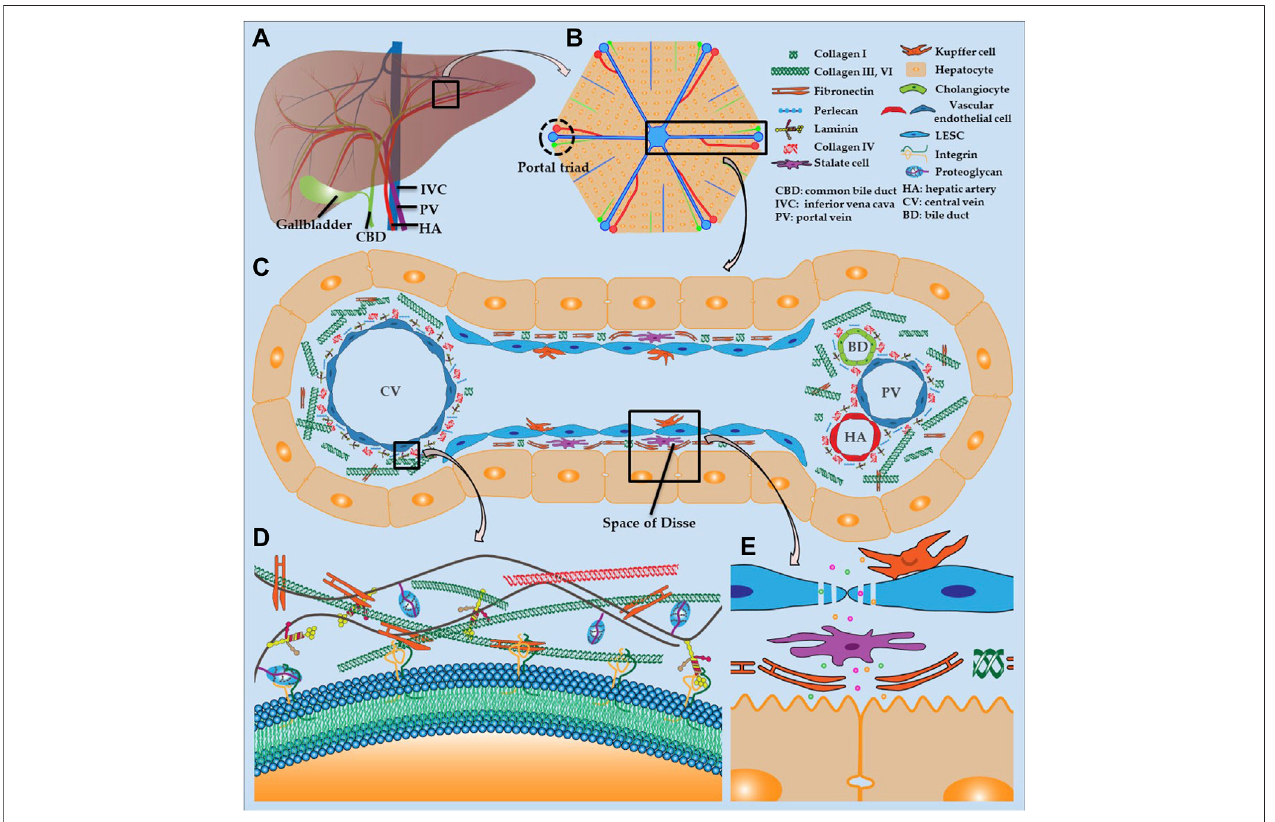
FIGURE2| Liver structure and hepatic ECM (A) Distributionofhepatic vasculature and bile ducts (B) Histology ofliver lobule (C) Compositionofhepatic sinusoids and ECM (D) ECM structure (E) Fenestration of LSECs and structure of space of Disse.